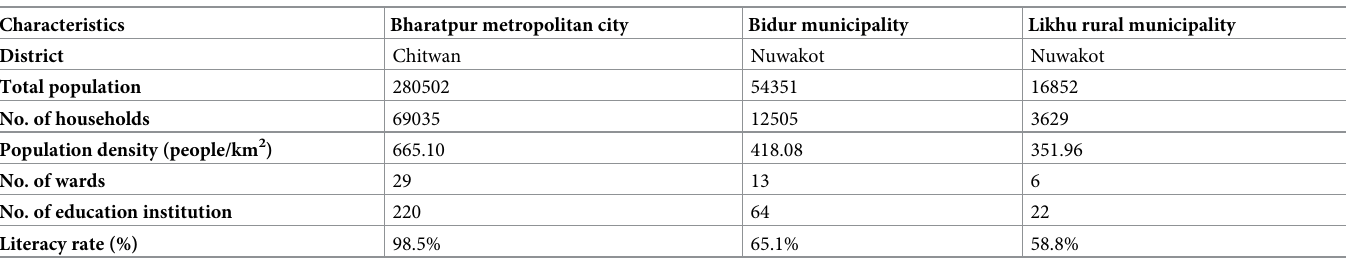
Table 1. Key characteristics of the study sites.